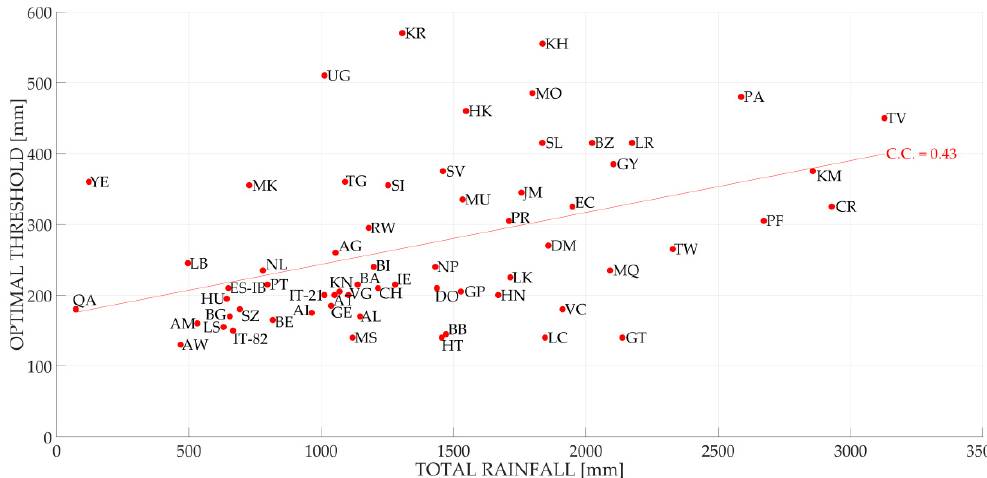
Figure A6. The optimal thresholds for every country object of study obtained using a false alarm cost equal to 1 and a missed alarm cost equal to 5 compared to the total rainfall of the country: The results refer to a 96-h aggregation interval. The countries naming follow ISO 3166.